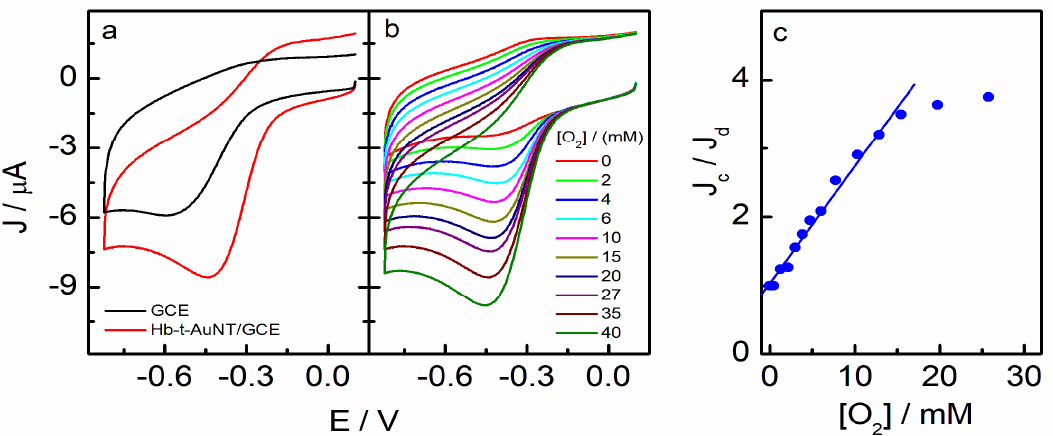
Figure 7. Electrocatalytic response of the Hb-t-AuNTs system for O 2 detection. ( a ) Cyclic voltammo- grams for the reduction of O 2 at equilibrium concentration recorded by using a bare GCE (black line), and one of the biosensors described in this work (red line) in a 10 mM phosphate buffer solution at pH 7.4; ( b ) Effect of the addition of increasing concentrations of O 2 ; ( c ) Catalytic efficiency as a function of O 2 concentration.